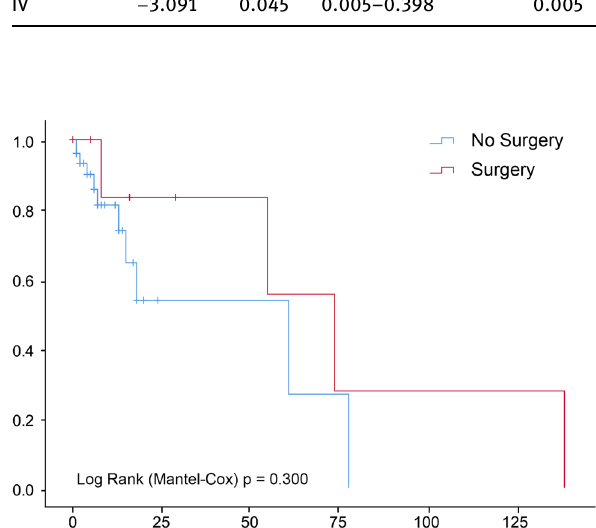
Figure 1: Surgery does not impact survival of patients with hepatoid adenocarcinoma of the lung.